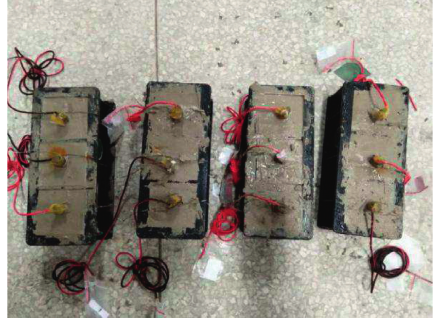
Figure 5: The actual cement soil samples.